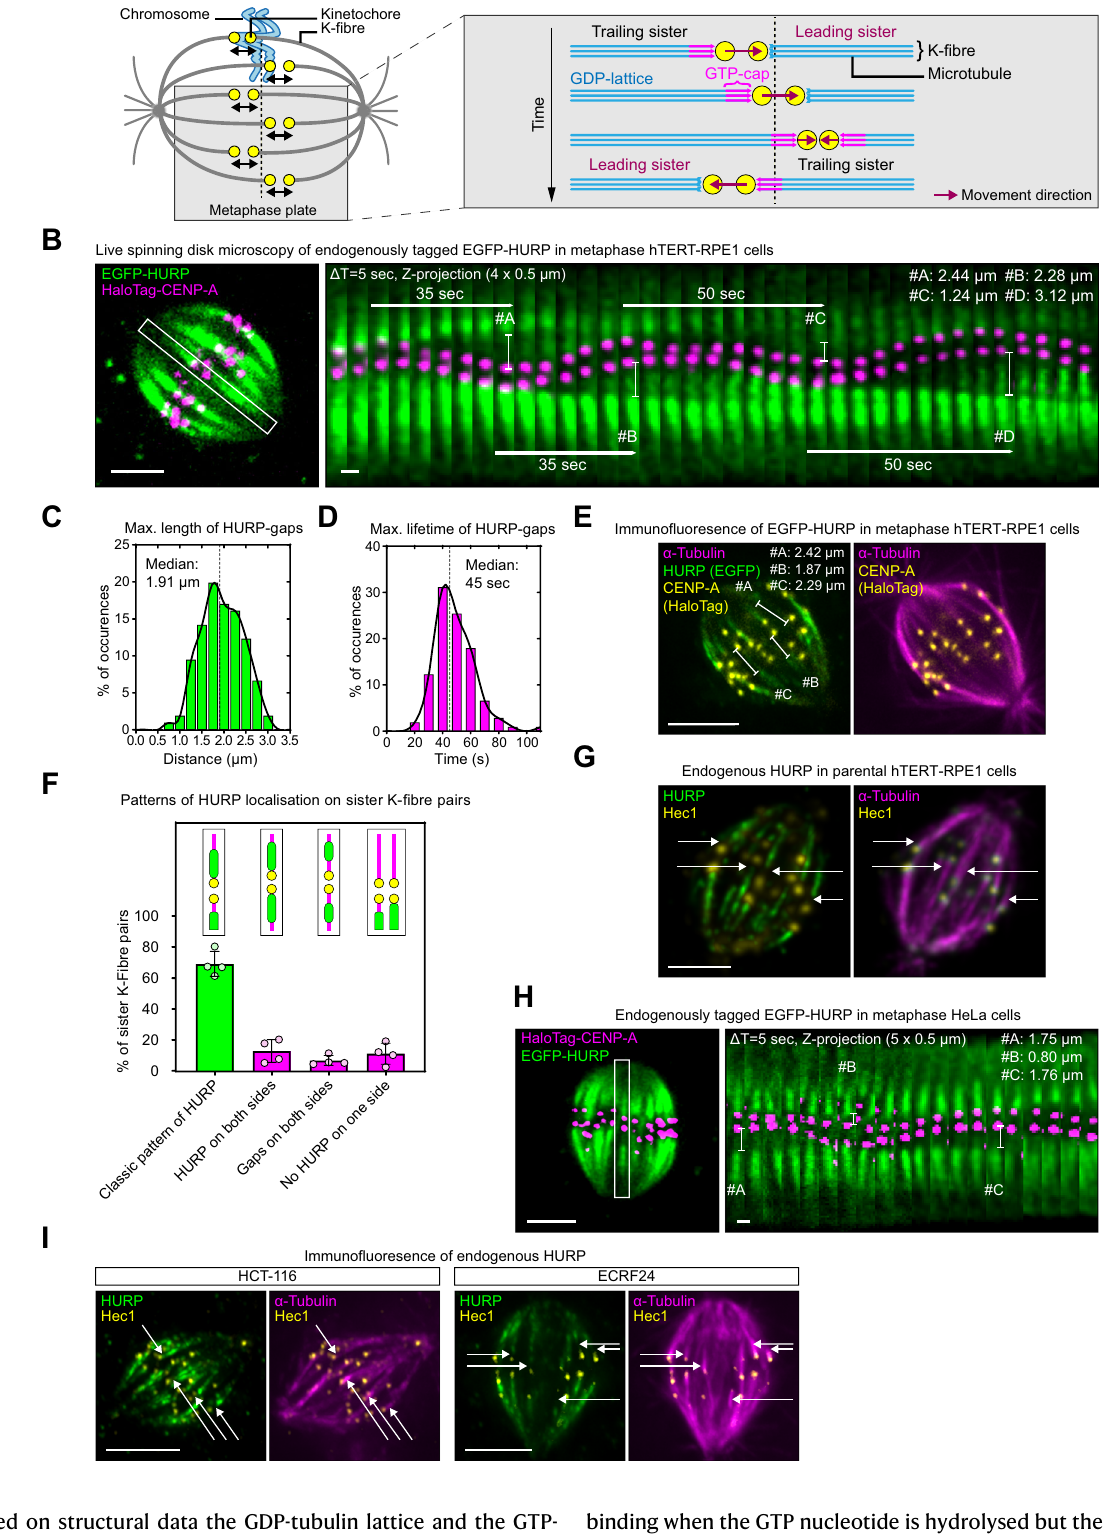
binding when the GTP nucleotide is hydrolysed but the γ -phosphate group has not yet been released 15 , and that they will only dissociate once the microtubule lattice is in the GDP-tubulin form 13 . Therefore, EBs are used in vitro and in vivo as markers of the GTP-tubulin cap 13,14,16 – 19 . On K- fi bres EBs accumulate on a narrow region of up to 100 nm, close to the kinetochore, consistent with the presence of a small GTP-cap 20,21